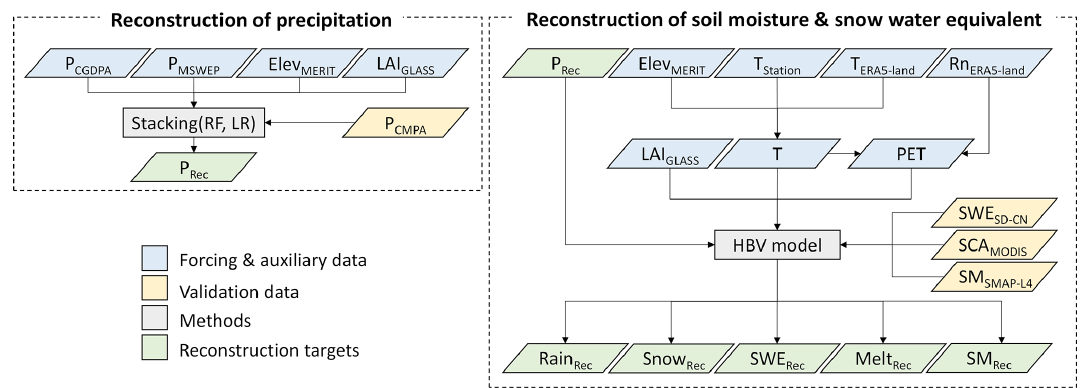
Figure 1. Workflow of the study. P : precipitation, Elev: elevation, LAI: leaf area index, T : air temperature, R n : net radiation, PET: potential evaporation, SWE: snow water equivalent, SCA: snow cover area, SM: soil moisture, Rain: liquid rainfall, Snow: snowfall, Melt: snowmelt, RF: random forest, LR: linear regression.